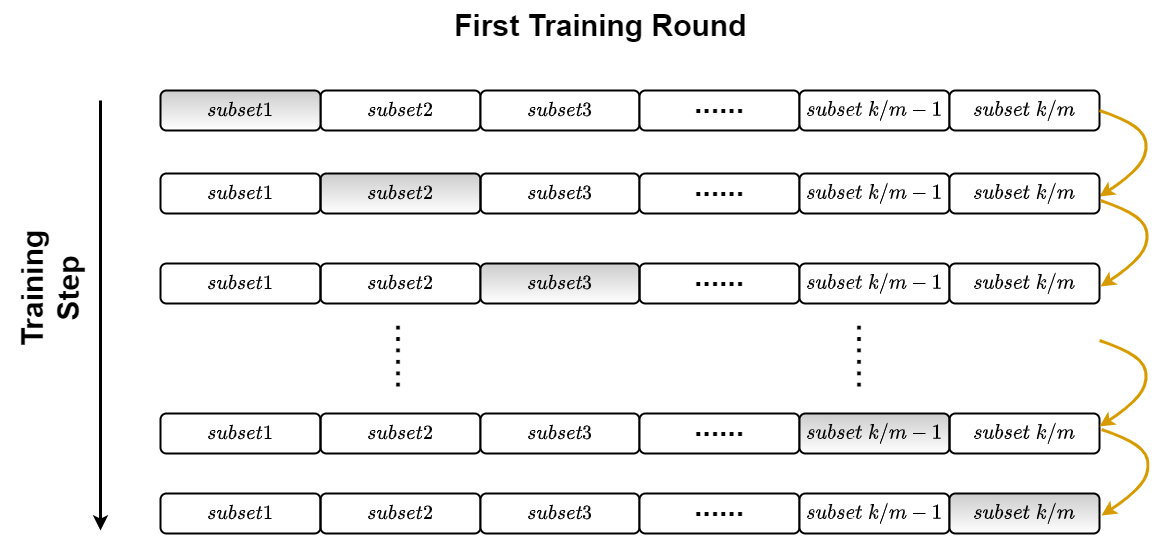
Figure 4. An overview of the first-round pre-learning. The challenge bits of a subset in color are randomly generated, and the rest of the bits are